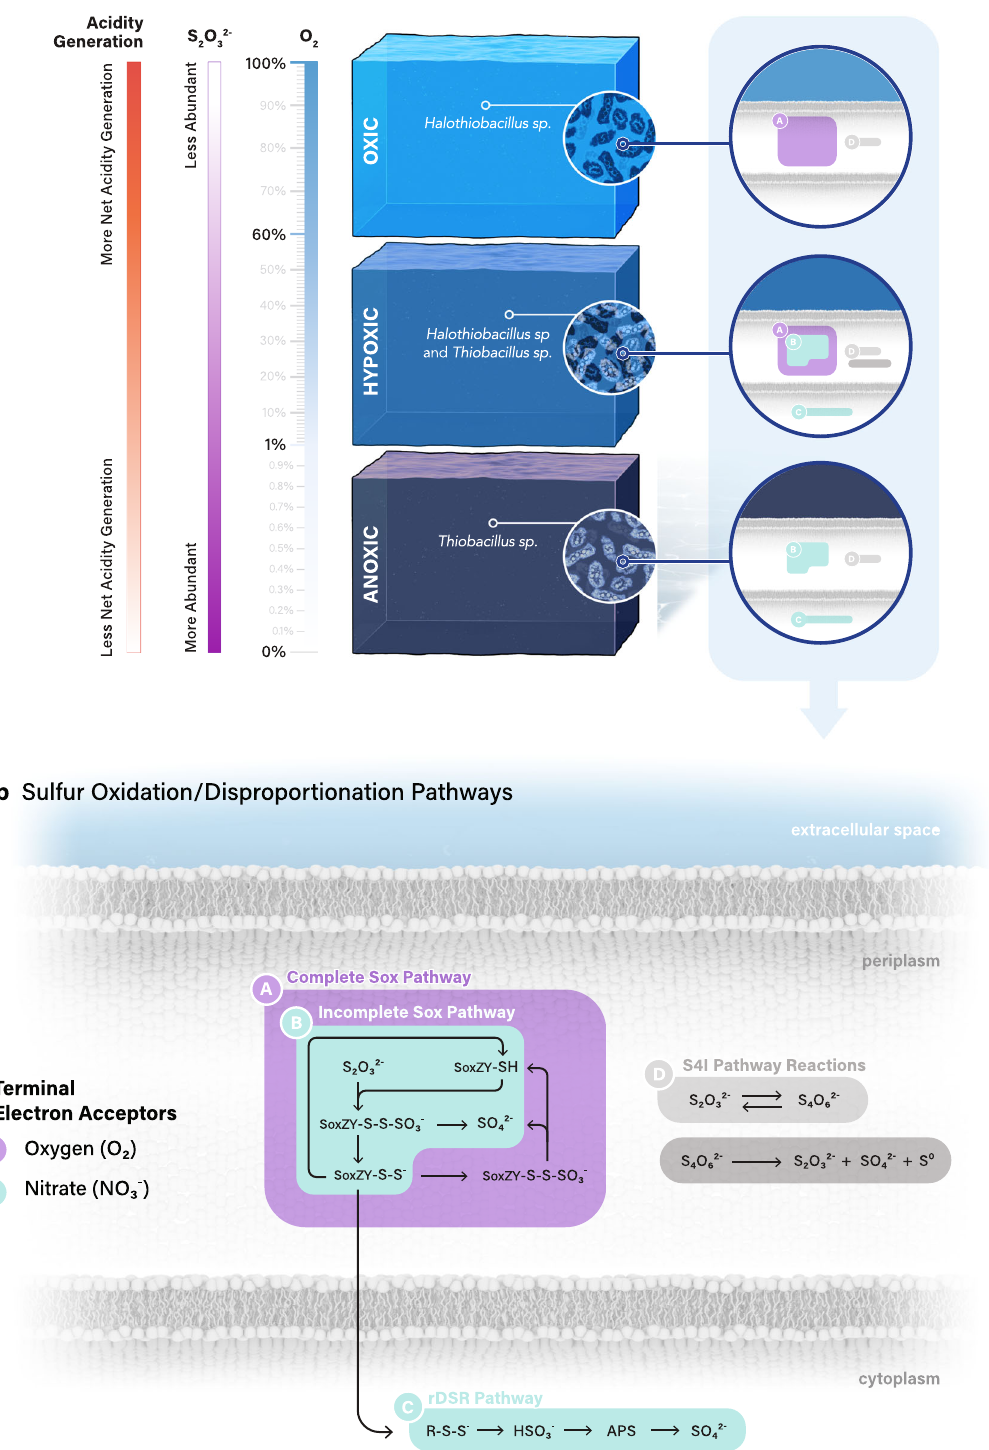
Fig. 5 | Conceptual model of differential microbial sulfur oxidative strategies throughout steep oxygen zonations. a Dissolved O 2 zones, and dominant microbial oxidative strategy, based on gene expression, in the oxic zone (Sox drivenoxidationcoupledtoO 2 ),hypoxiczone(Sox-drivenoxidationcoupledtoO 2 and rDSR-driven oxidation coupled to NO 3 − ) and anoxic zone (rDSR-driven